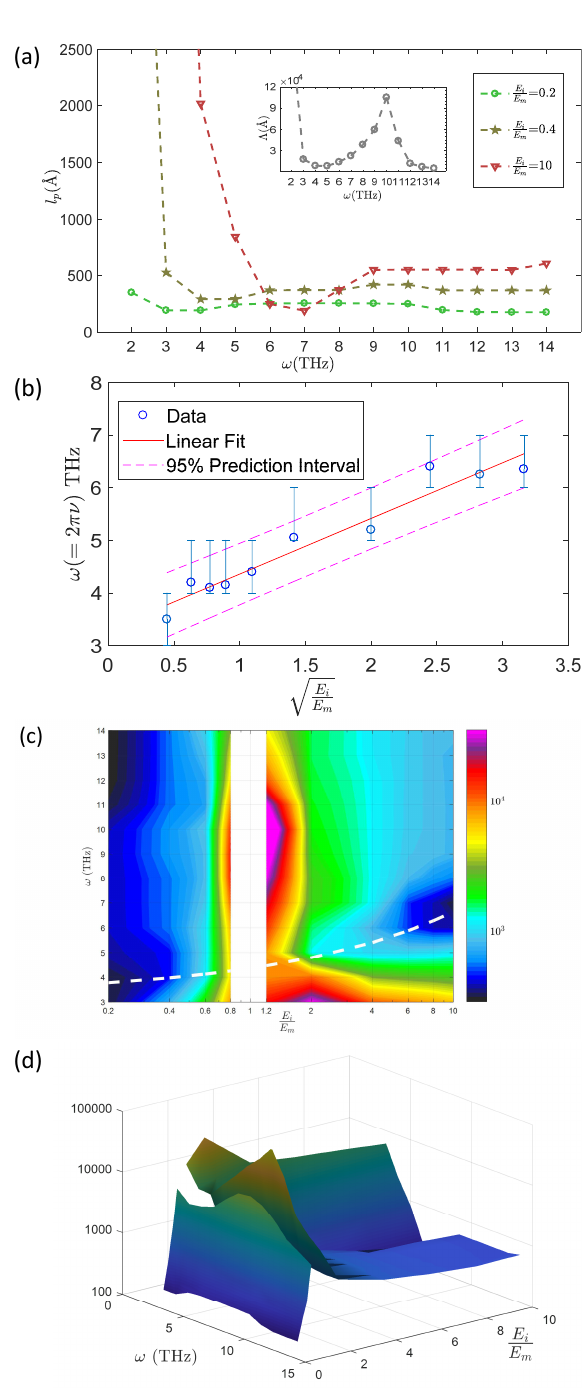
Figure 12. ( a ) Penetration length l p ( ω ) for E i = 0.2, 0.4 and 10.0, with r = 25 Å. Inset: mean free paths E m Λ vs ω for E i = 1.2 and r = 25 Å. ( b ) Frequency, which corresponds to the minimum l p for each E i E m function of the sound velocity in the inclusions. ( c ) color representation of the penetration length in the parametric space ( E i / E m , ω ) ( d ) Idem in a 3D plot. ( d ) 3D plot of the prenetration length in the arametric space ( E i / E m , ω